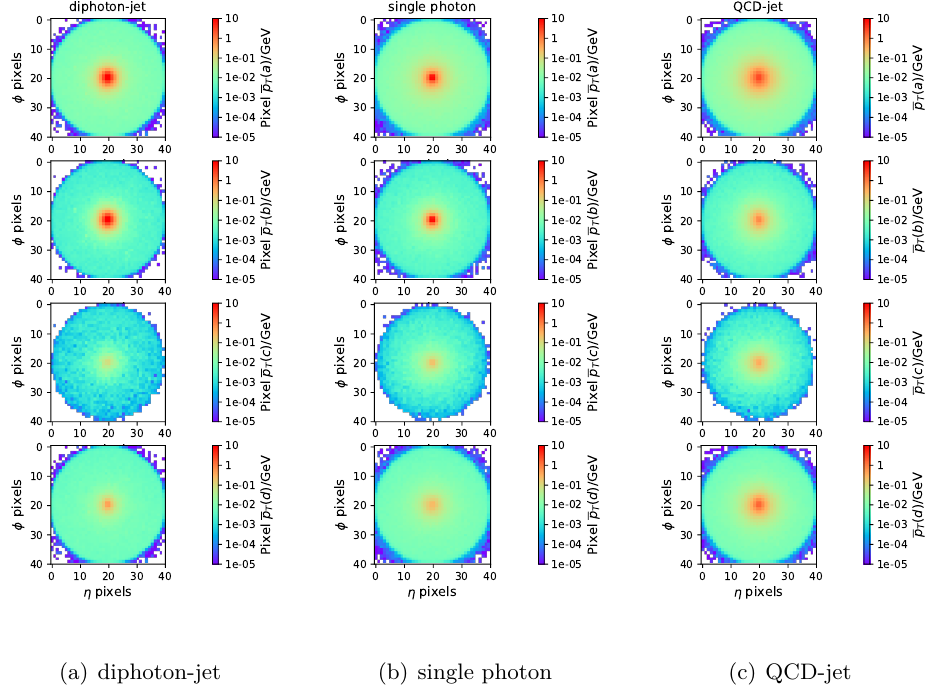
Figure 6 . The jet images for three kinds of jets after applying the translation and rotation steps of the pre-processing. The three kinds of jets are the leading jets of the benchmark signal events with g = 0 . 64 TeV − 1 and m = 3 GeV, the leading jets of the W ± γ background events and the aγγ a leading jets of the W ± j background events after basic selection. The pixel intensities of the four channels, defined by the sum of the transverse momentum of all the particles, the photons, the charged hadrons and the neutral hadrons, are labeled as p , p , p and p , respectively. Ta Tb Tc Td